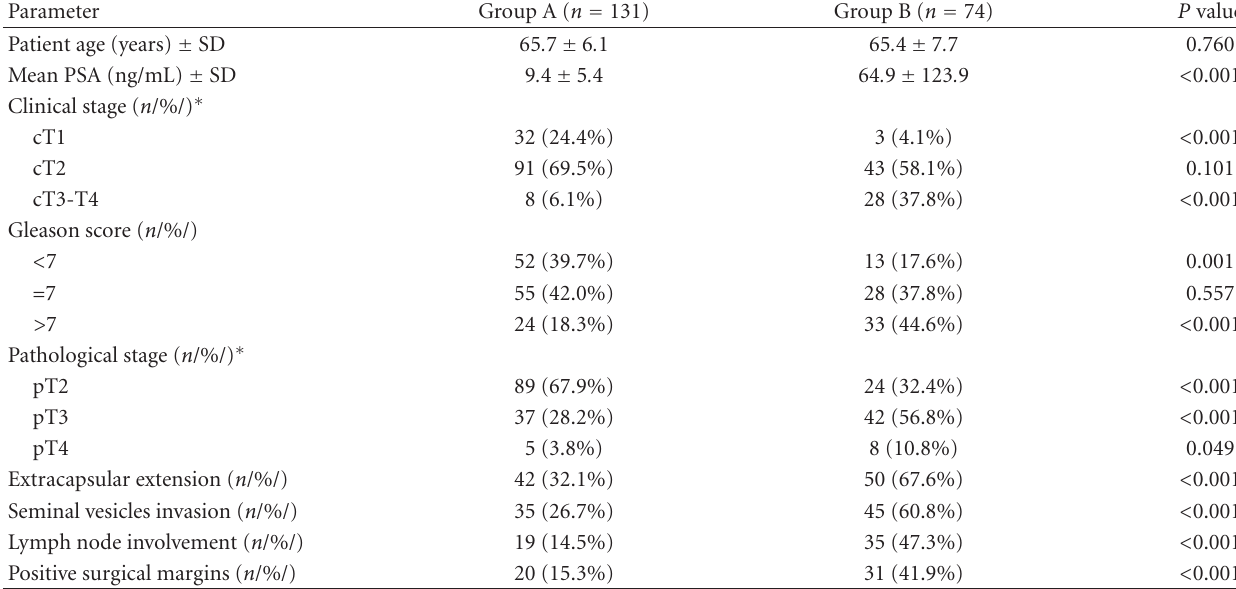
Table 1: Patient characteristics and pathological